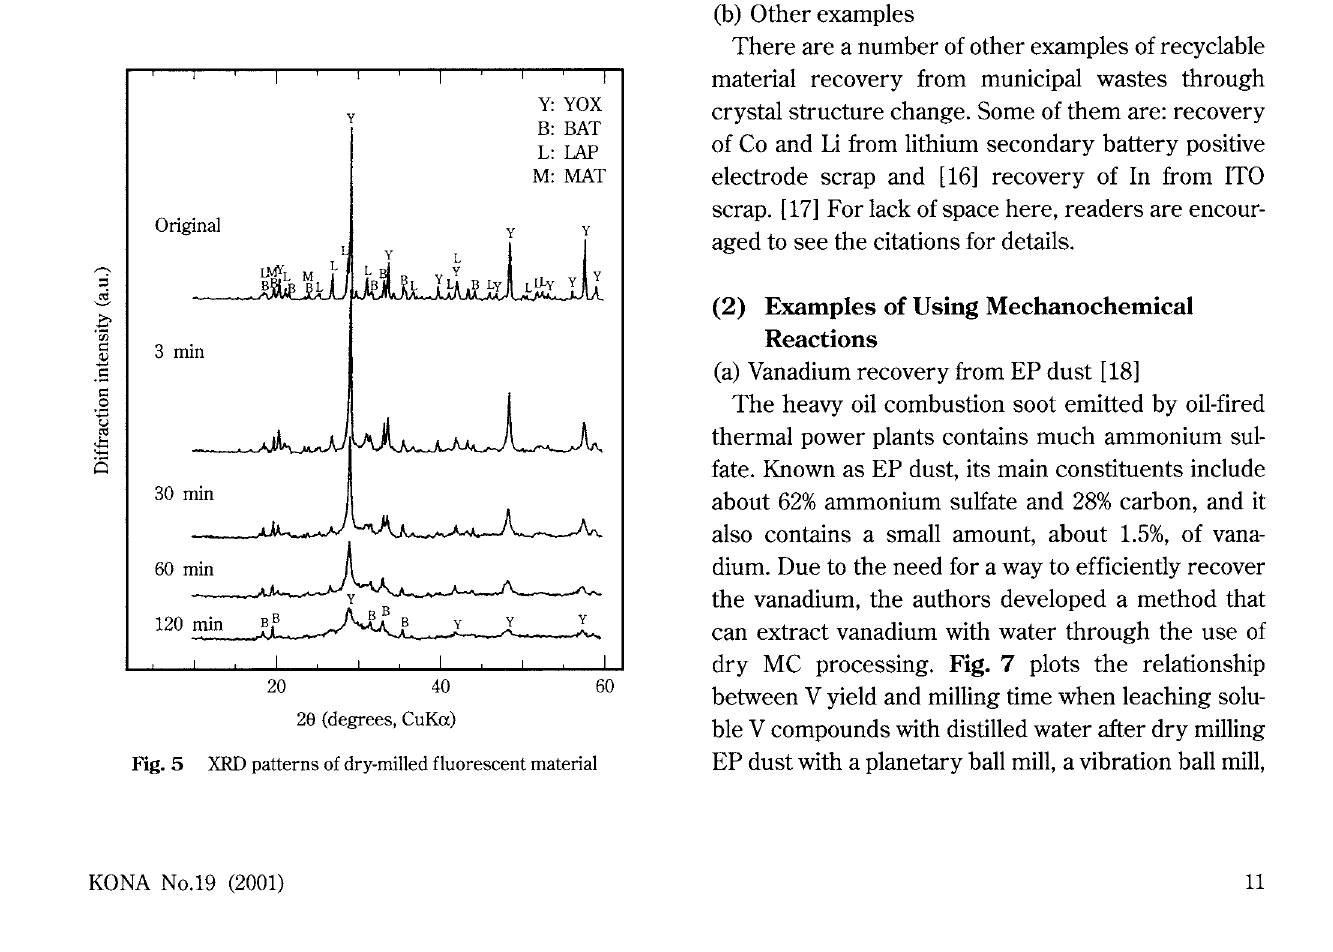
KONA No.19 (2001)